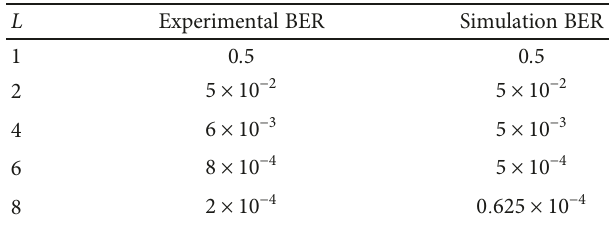
Figure 7: BER versus the number of blocks of RSTBC for experimental, simulation, and analytical upper bounds, in a 2 × 2 MIMO-OFDM system, with 16-QAM and loss rates of 10% and 25%. Table 2: BER numerical results for 10% loss rate when RSTBC is applied with L = 1, 2, 4, 6, 8